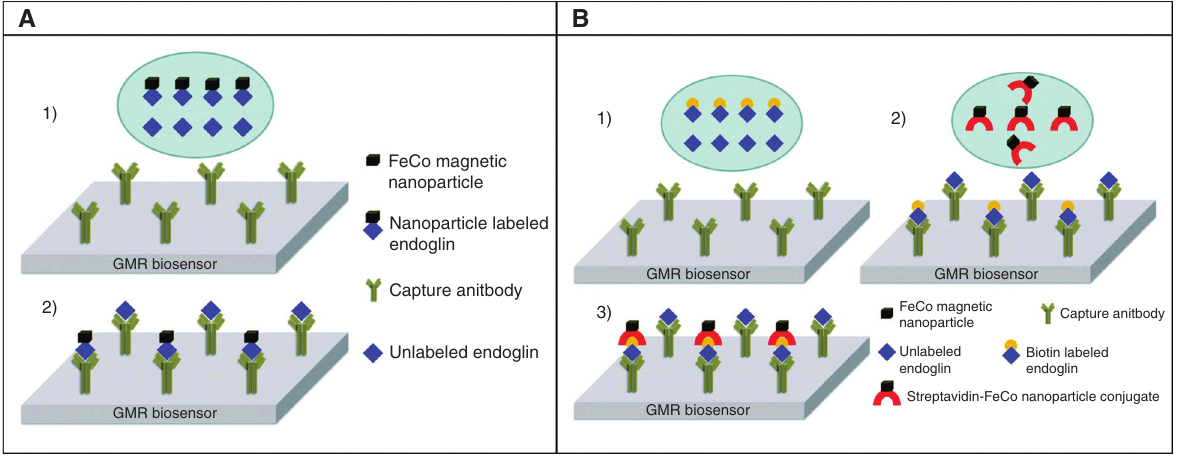
Figure 6 (A) Two-layer competition detection scheme. The GMR sensors were first functionalized with capture antibodies (a1). Nanoparti- cle-labeled endoglin and unlabeled endoglin were then mixed and applied on the sensor surface to compete for capture antibodies (a2). (B) Three-layer competition detection scheme. The GMR sensors were first functionalized with capture antibodies. Biotin-labeled endoglin and unlabeled endoglin were then mixed and applied on the sensor surface to compete for capture antibodies (b1). Subsequently, streptavidin- FeCo nanoparticle conjugates were applied for binding (b2 and b3). (Reproduced with permission from Ref. [101], Copyright ACS Publica- tions,